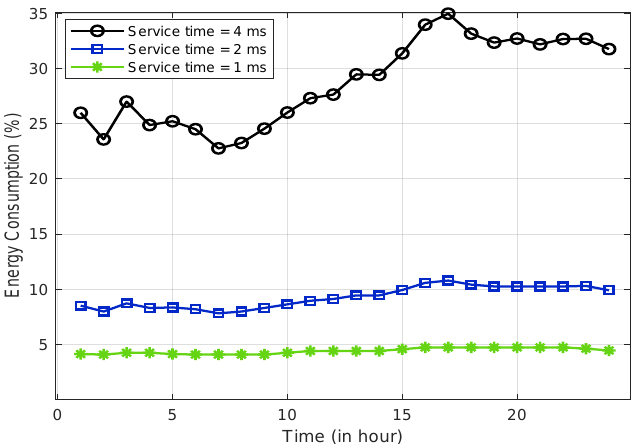
Figure 9. Energy consumption of a fog computing infrastructure under 20 ms and 40 ms delay requirements in the proposed GDAFC.